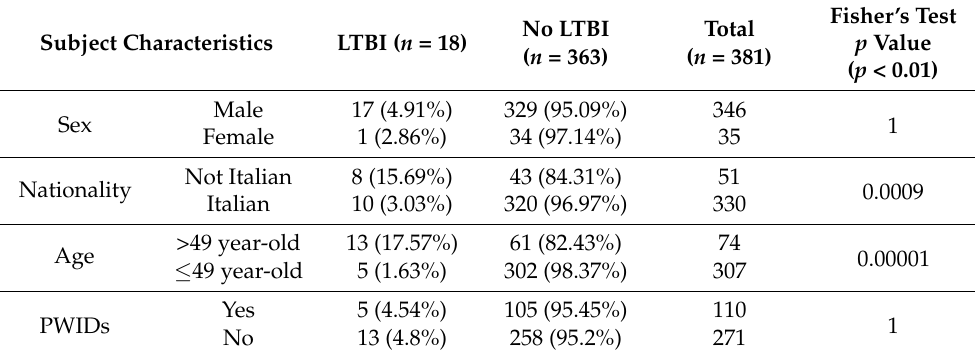
Figure 1. A flowchart of our inmates’ tuberculosis screening protocol. Table 4. The data were statistically analyzed. Fisher’s exact test was performed ( p value < 0.05). The test showed a significant statistical correlation between LTBI and the variables age (age older than 49 years) and nationality (not Italian people). The low frequency of comorbidities among the LTBI-positive group, as well as the fact that all the positive subjects attended only compulsory school, did not allow performing further analysis on these variables. LTBI indicates latent tuberculosis infection; PWIDs, people who inject drugs.